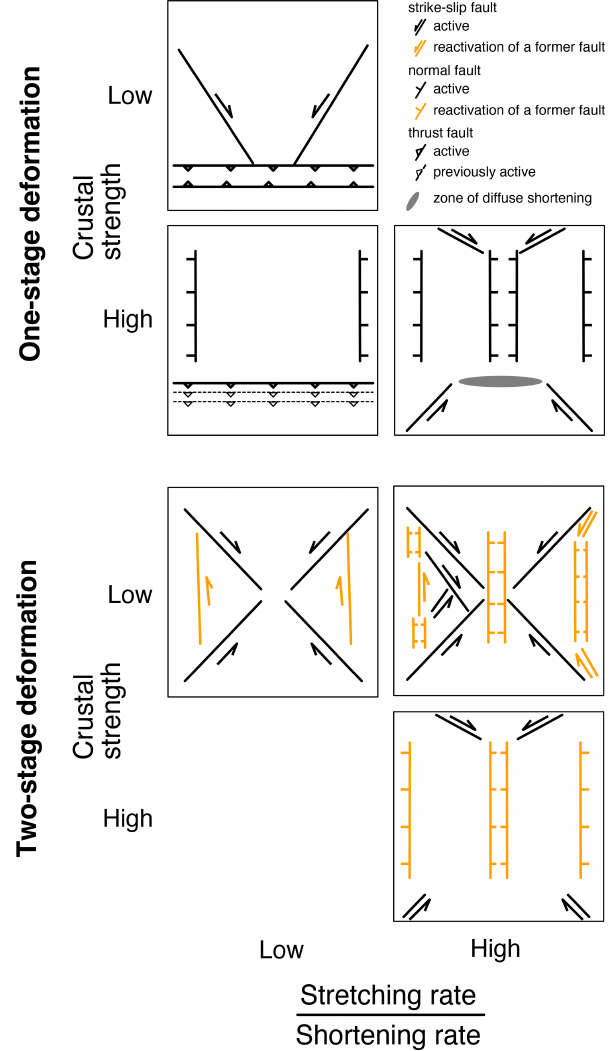
Figure 11. Synthesis of map view structures observed as a function of crustal strength, ratio of stretching/shortening rates, and tectonic inheritance. For the two-stage deformation, newly formed faults are in black and reactivated faults are in